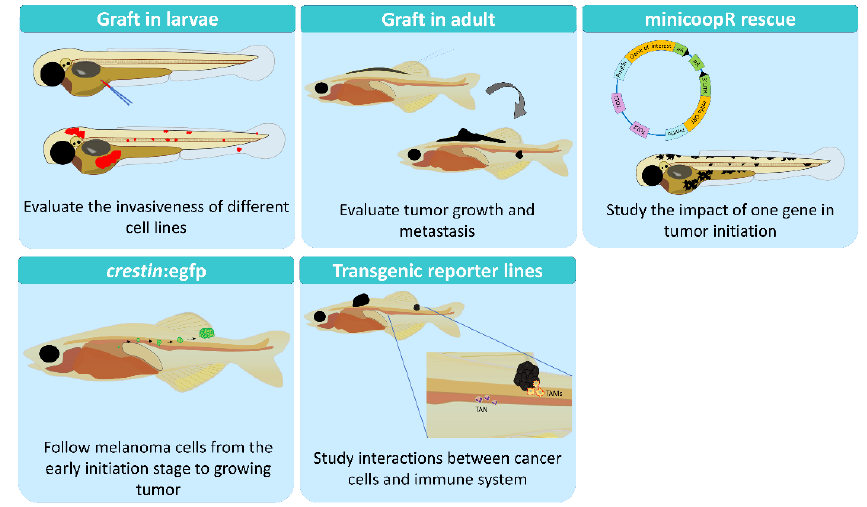
Figure 2. Zebrafish tools to study melanoma in vivo. GOI, gene of